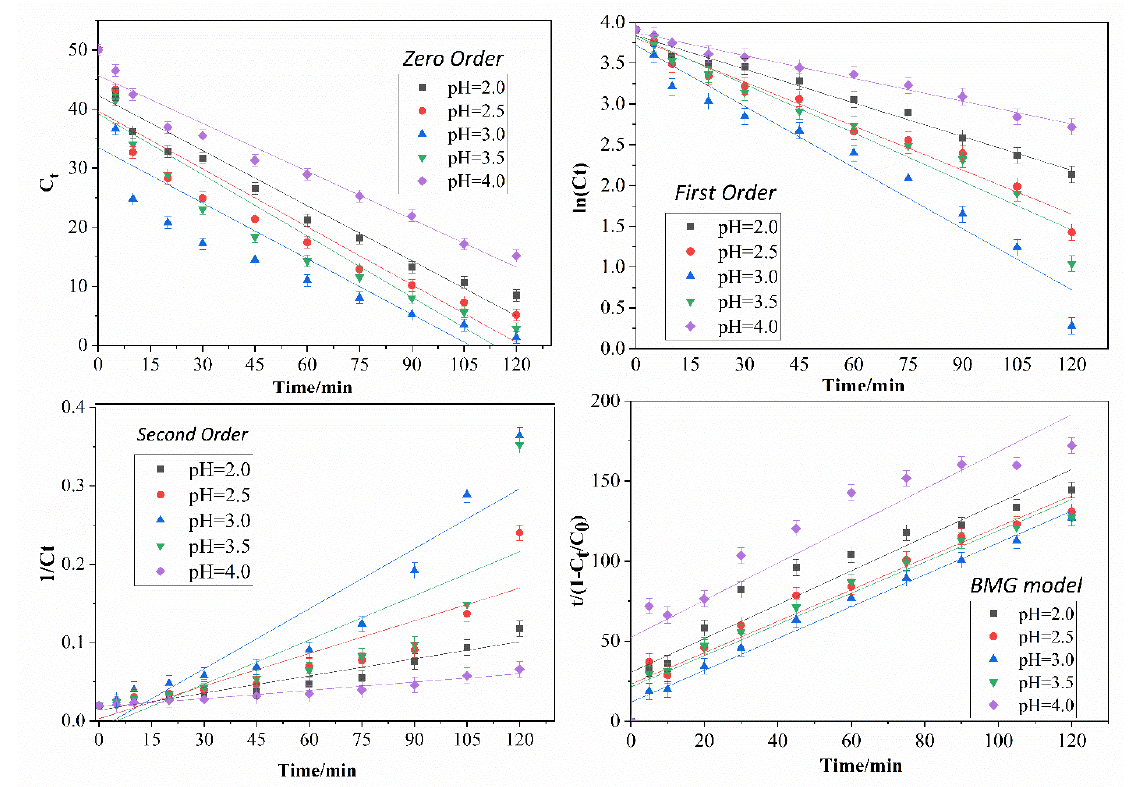
Figure 6. Degradation data of glyphosate using different kinetic models under different pH.